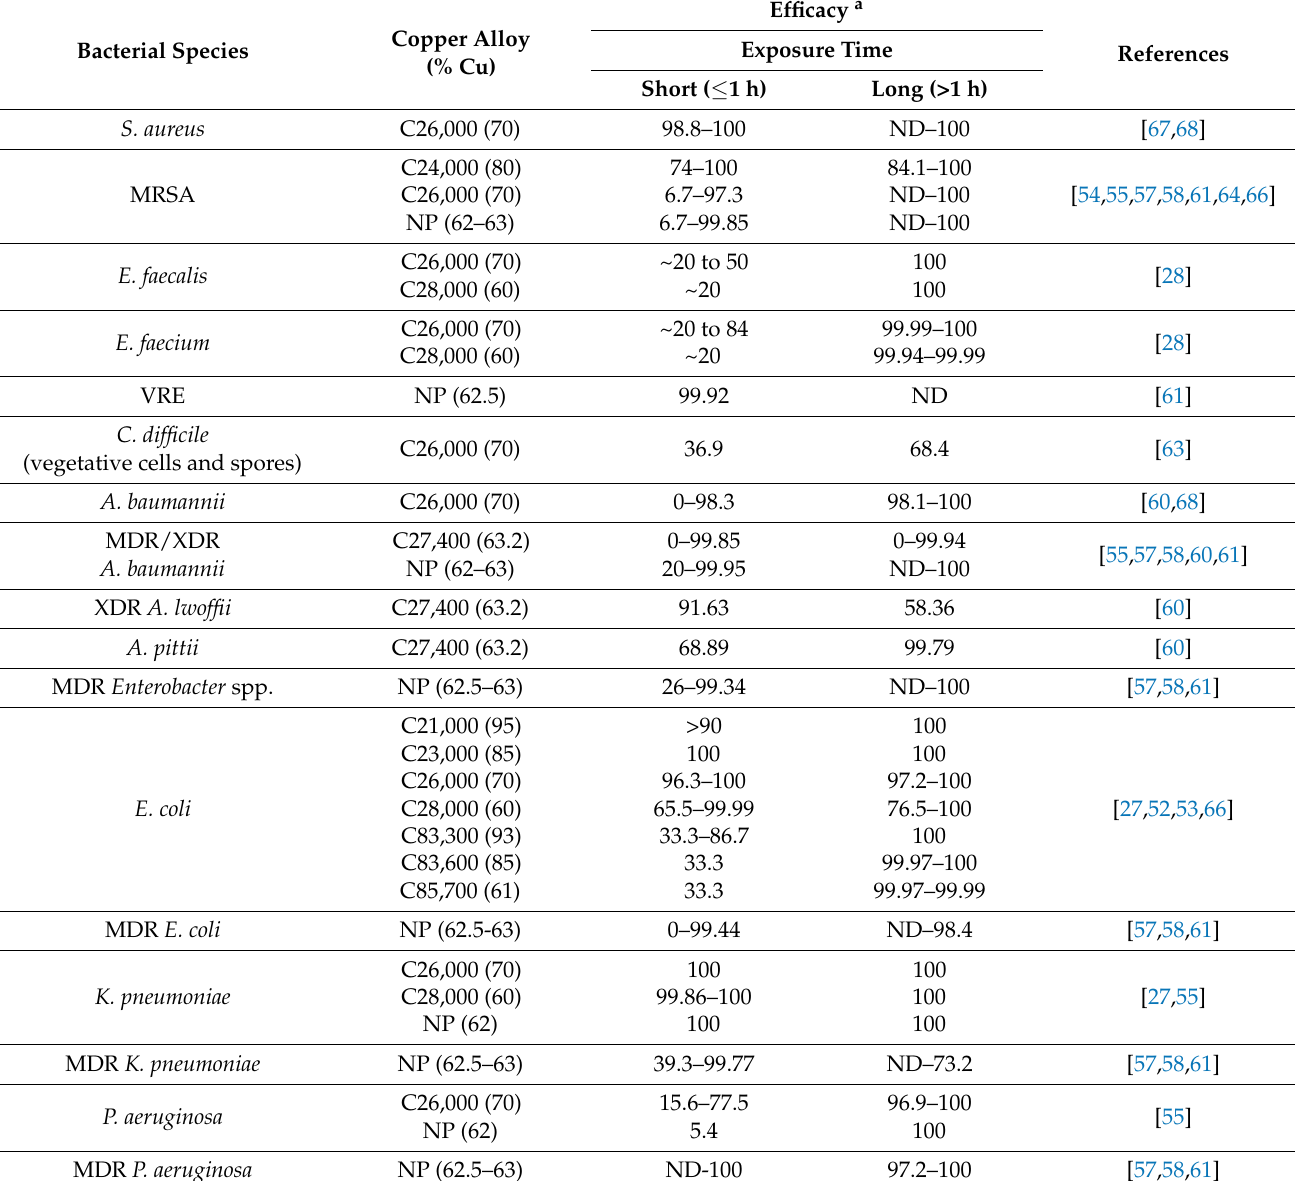
Table 1. Antibacterial activity of brass surfaces on selected nosocomial